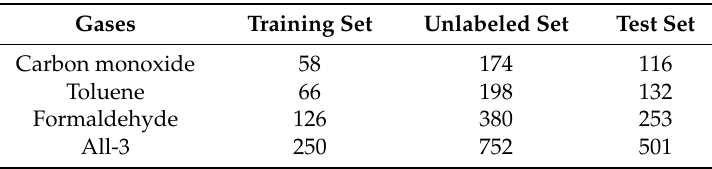
Table 3. Amount of samples in a data set with 75% unlabeled